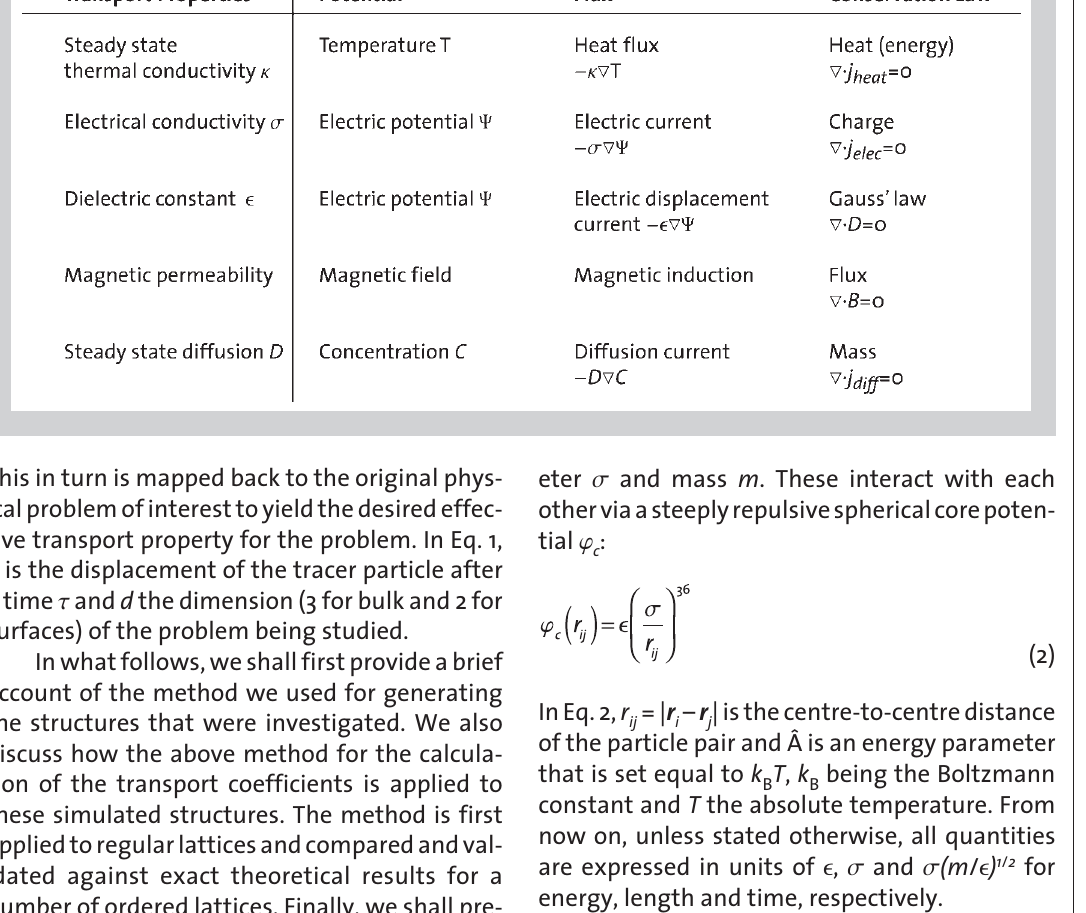
Table 1: Effective Transport Proper- ties and their underlying governing equations for a number of different physical Transport